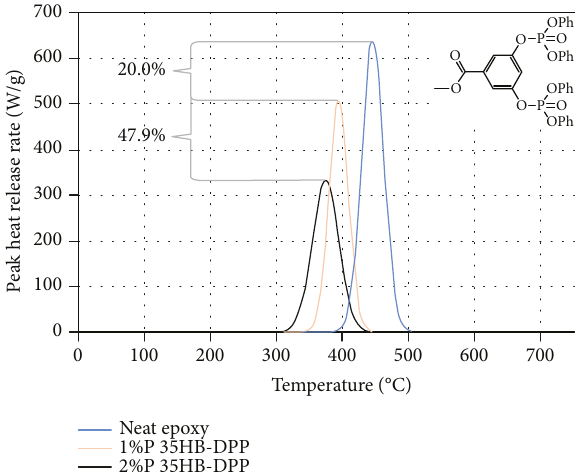
Figure 6: Peak heat release rates for blends of methyl 3,5-di(diphenylphosphato)benzoate in DGEBA epoxy.